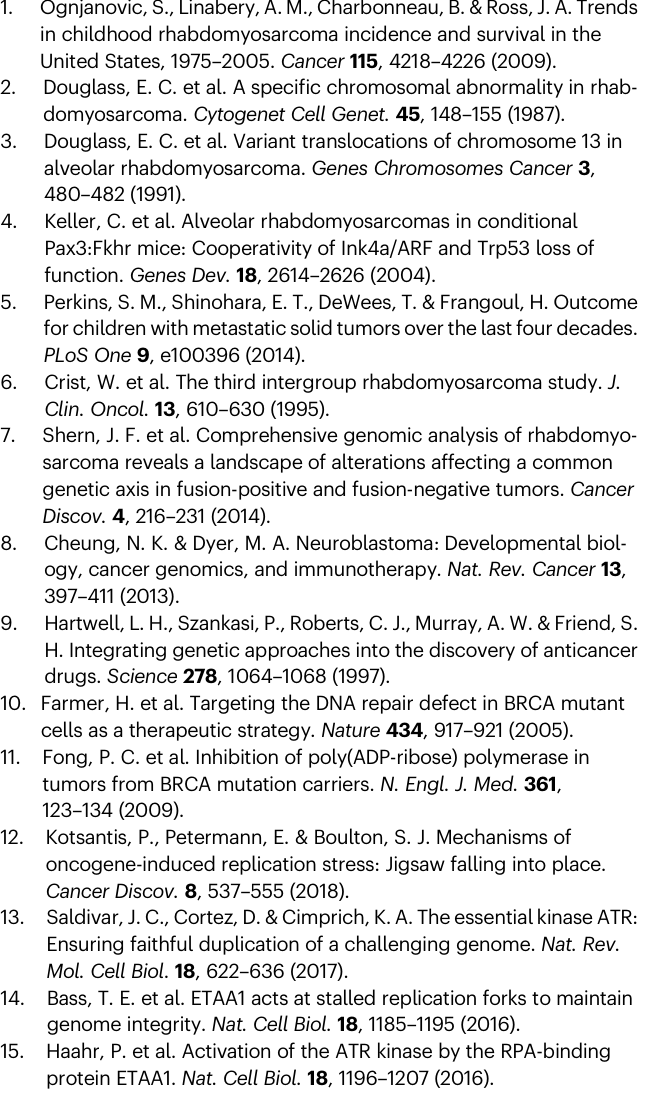
RNA-seq of ATR inhibitor resistant